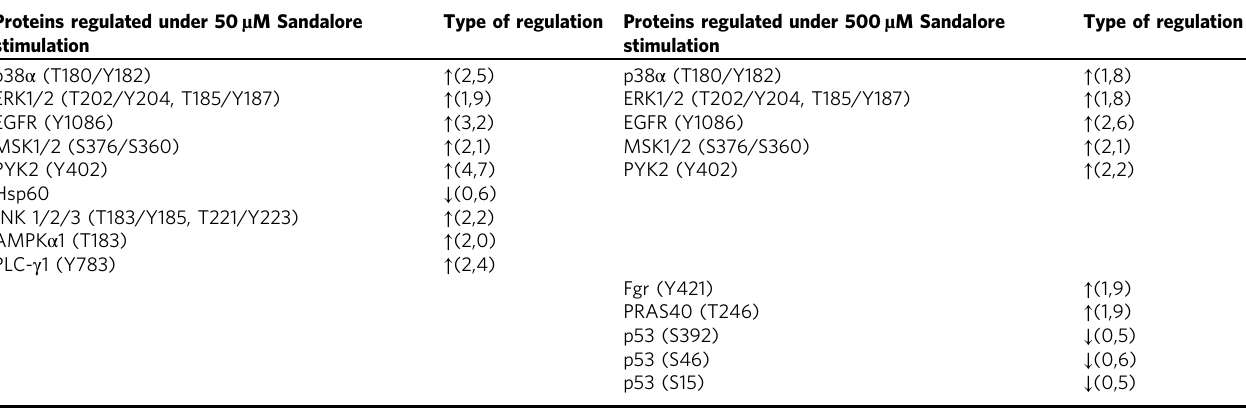
Table 1 OR2AT4 stimulation by Sandalore ® treatment regulates different signaling protein phosphorylation pathways in human HFs ex vivo Proteins regulated under 50 µ M Sandalore stimulation